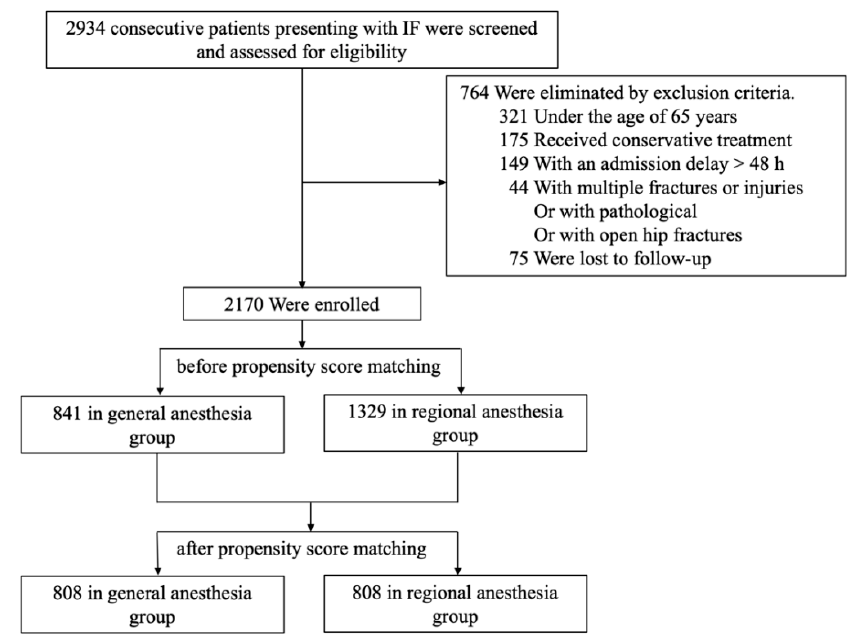
Figure 1. Flow diagram of included patients.